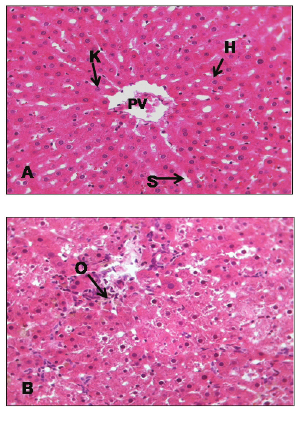
Figure 1 - H & E staining on liver tissue of (A) control group (given a normal diet) (B) CDE group without treatment of CV (liver cancer was induced with 0.1% ethionine in drinking water plus a choline-deficient diet). H: Hepatocyte, K: Kuppfer cell, PV: Portal vein, S: Sinusoid, O: Oval cell